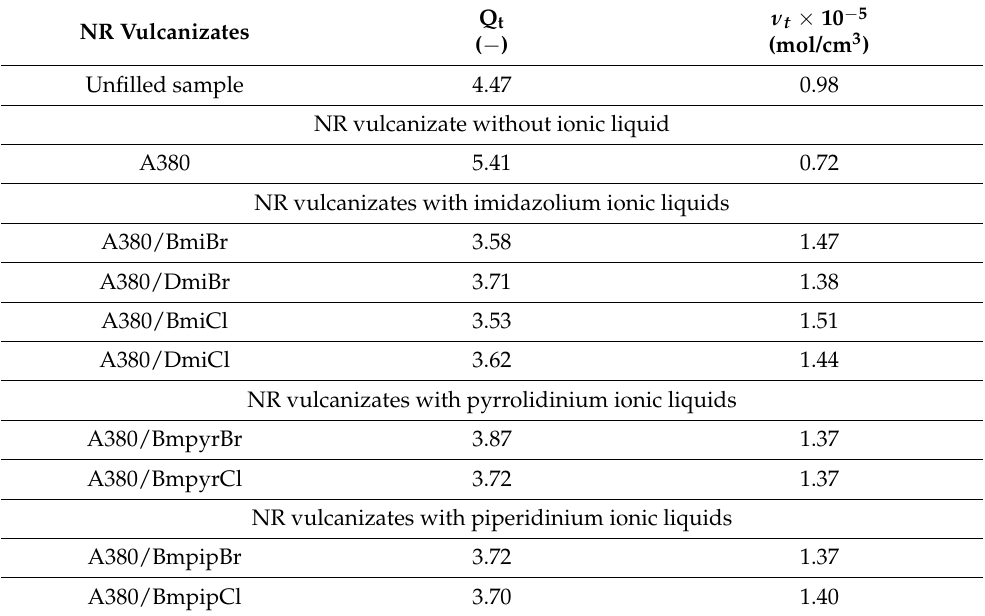
Table 5. Equilibrium swelling in toluene (Q t ) and crosslink density ( ν t ) of the silica-filled